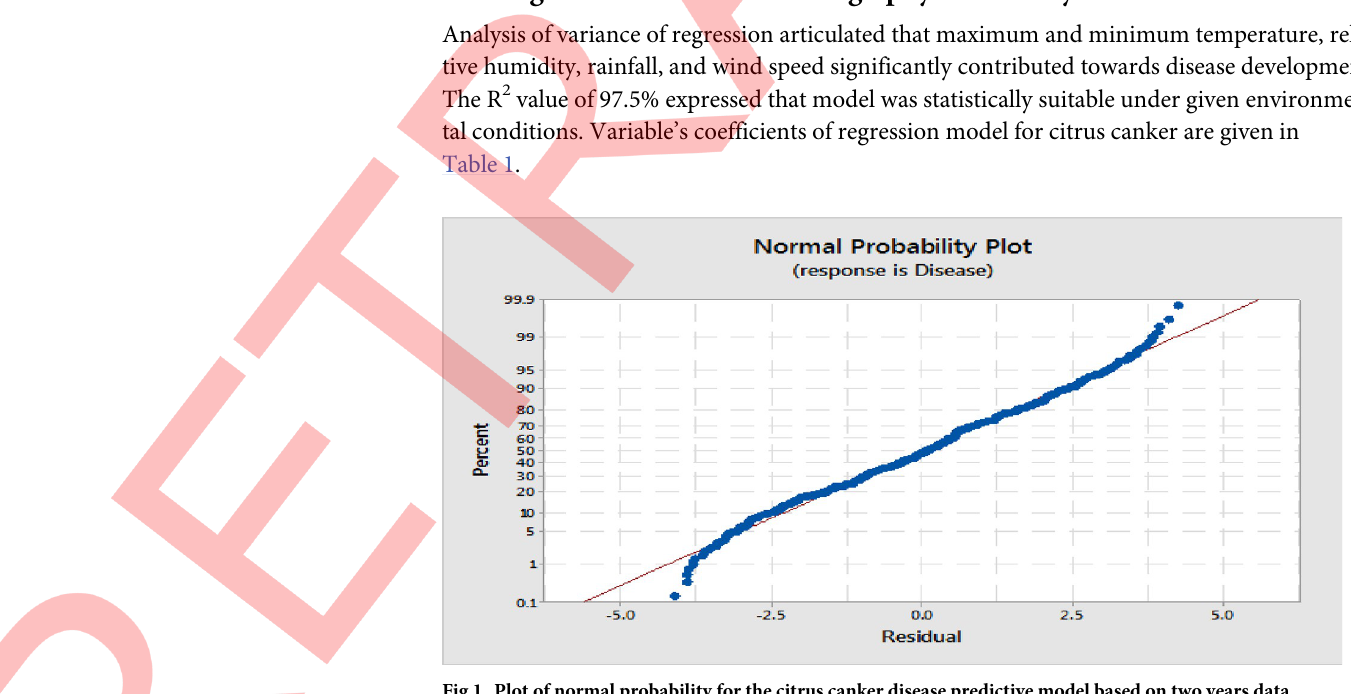
Fig 1. Plot of normal probability for the citrus canker disease predictive model based on two years data.